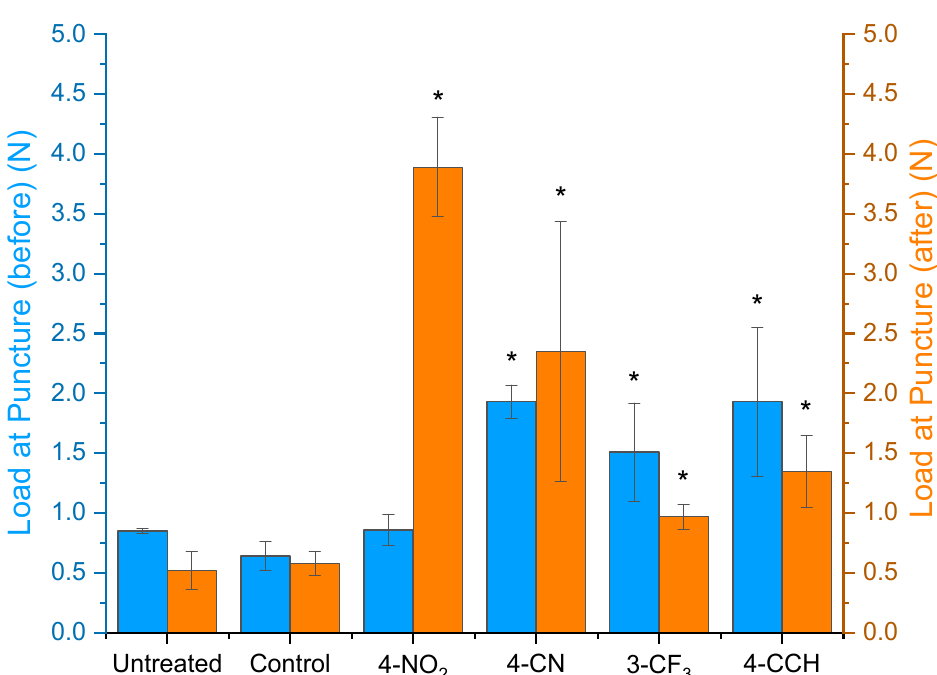
Figure 7. Changes in puncture load (left) and extension at puncture (right) for all treated samples including untreated and control samples, after being rehydrated in a steam bath. Errors are standard deviation, * denotes statistically significant di ff erence to untreated sample, p < 0.05.